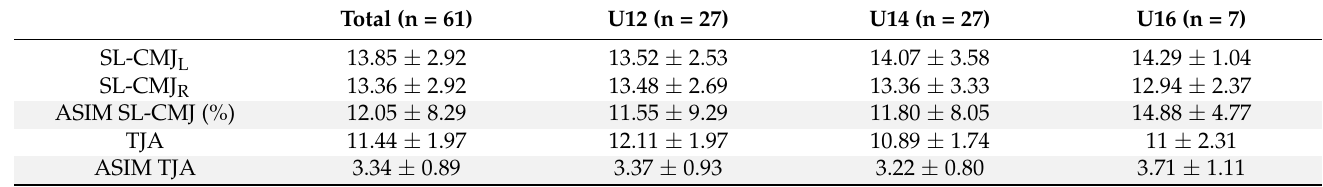
SL-CMJ L : vertical countermovement jump with left leg; SL-CMJ R : vertical countermovement jump with right leg; ASIM SL-CMJ(%): asymmetry magnitude in the vertical single leg countermovement jump test expressed with percentage; TJA: Total score, Tuck Jump Assessment; ASIM TJA: sum of criteria 3, 5 and 6 corresponding to the asymmetry risk factor (leg